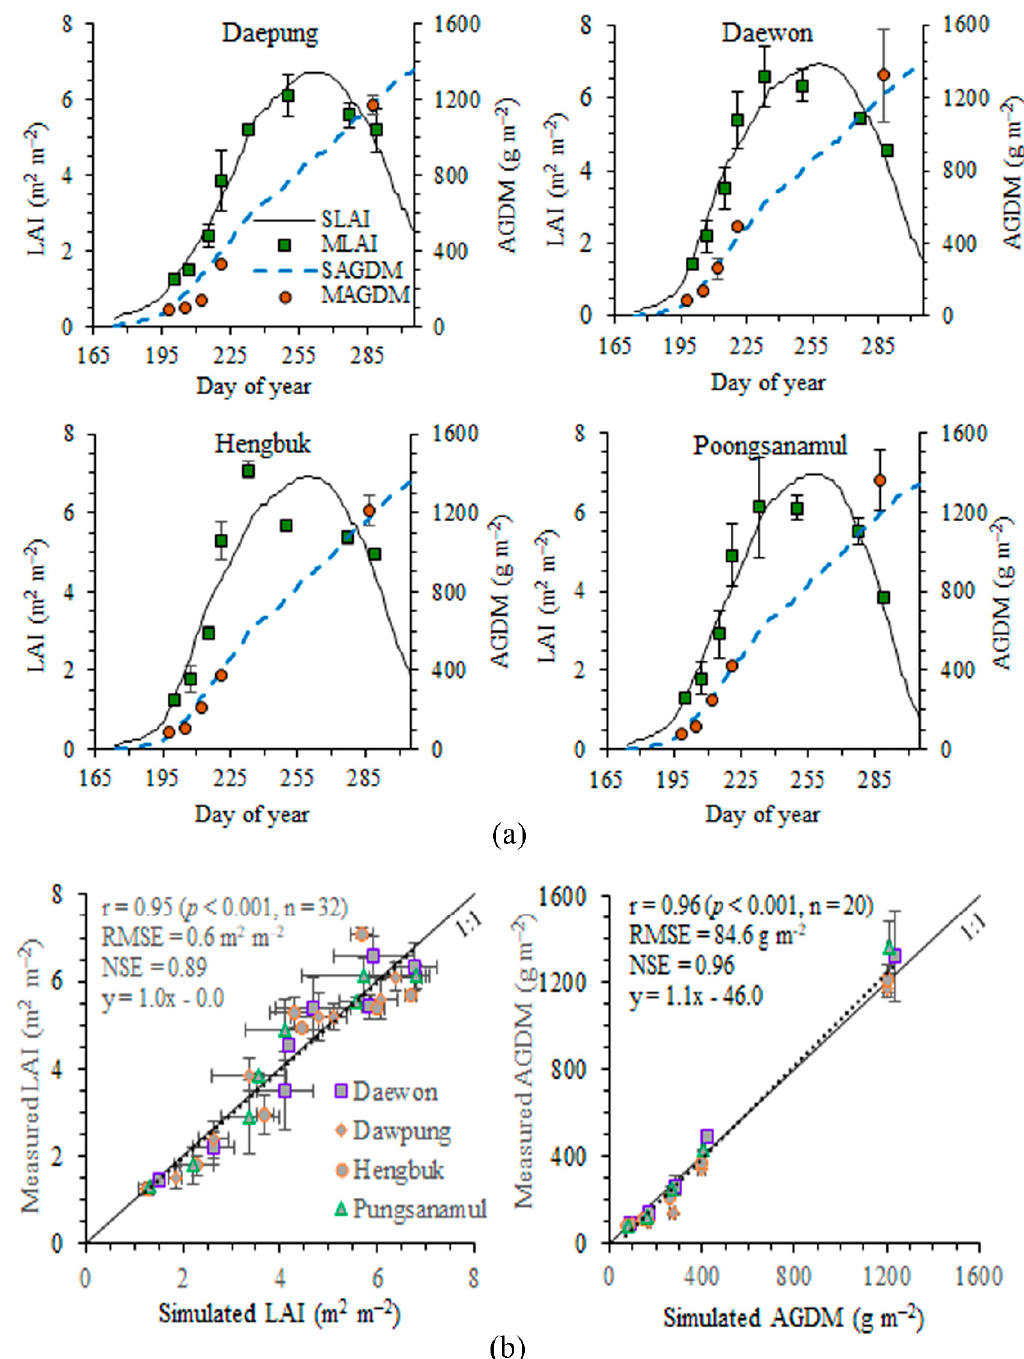
Figure 6. Model validation: Simulated (S) and measured (M), observed (O) values in LAI and S and M values in above-ground dry mass (AGDM) for four soybean cultivars, Daepung, Daewon, Hengbuk, and Poongsan based on the leaf area index (LAI) input option ( a ) and comparisons between S and M values in LAI and AGDM ( b ). Data were obtained at Chonnam National University, Gwangju, South Korea, in 2018. Vertical and horizontal error bars represent ± 1 SD of the means values. The solid and dotted lines in the panel ( b ) represent the ratio 1:1 and a linear fit, respectively. NSE, RMSE, and r denote Nash-Sutcli ff e e ffi ciency, root mean square error, and Pearson’s correlation coe ffi cient, respectively .